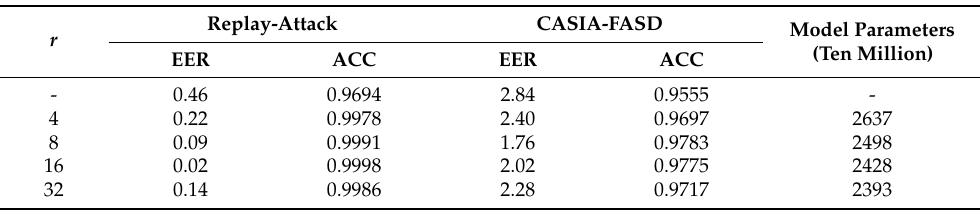
Table 2. Comparison table of results for parameter r .